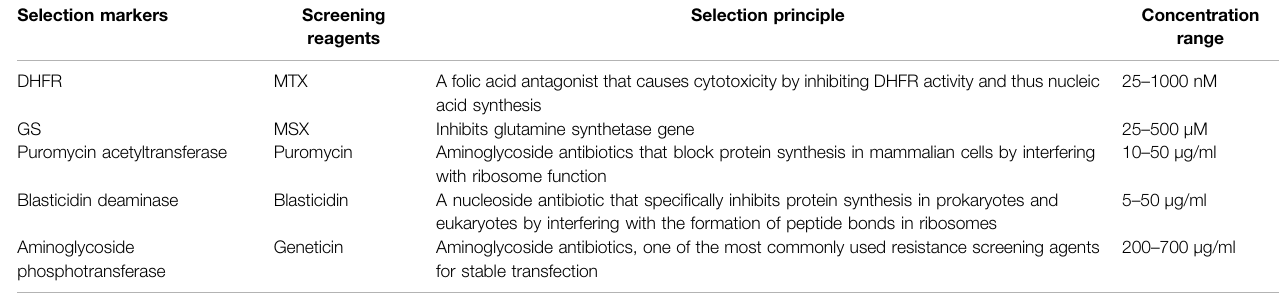
TABLE 1 | Common selection markers used in cell line development. Selection markers